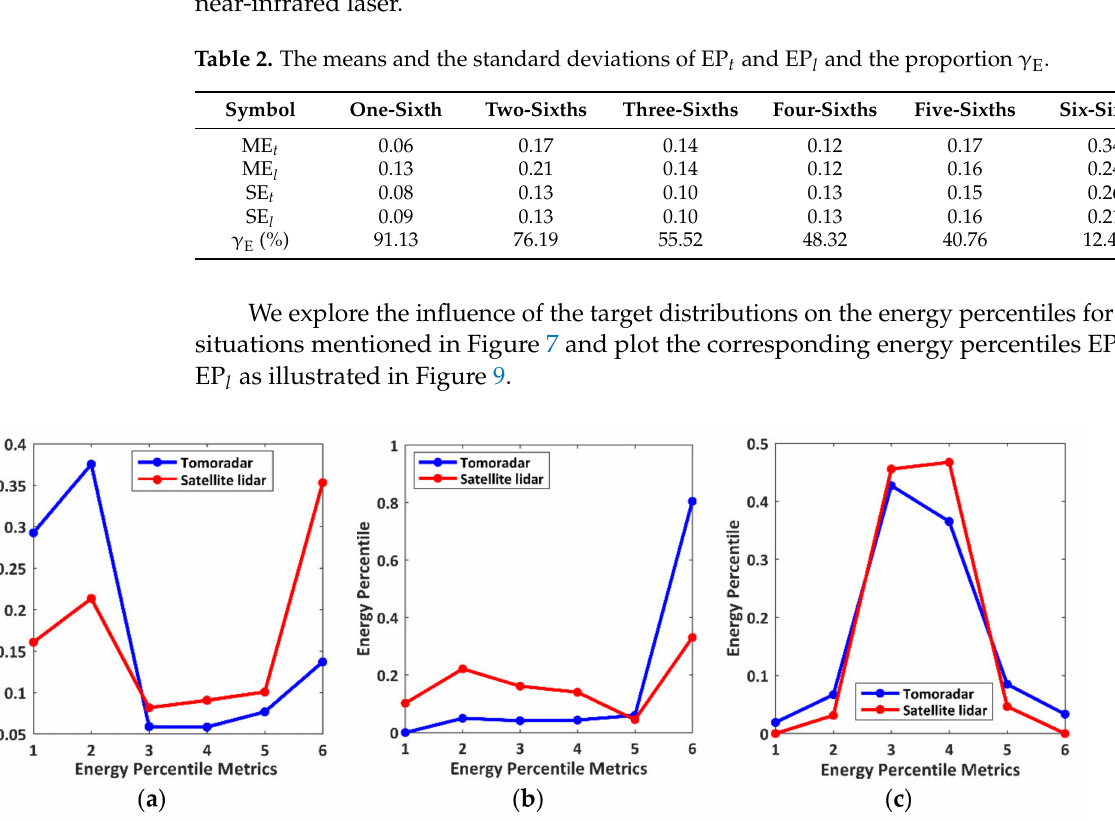
Figure 9. The height percentile distributions derived from Tomoradar waveforms and satellite lidar waveforms for three typical situations in Figure 7. ( a ) HP t is much larger than HP l ; ( b ) HP t is much smaller than HP l ; ( c ) HP t is approximately equal to HP l . The numbers from 1 to 6 along the x-coordinate directions represent the energy percentiles metrics from E 1 to E 6 ,